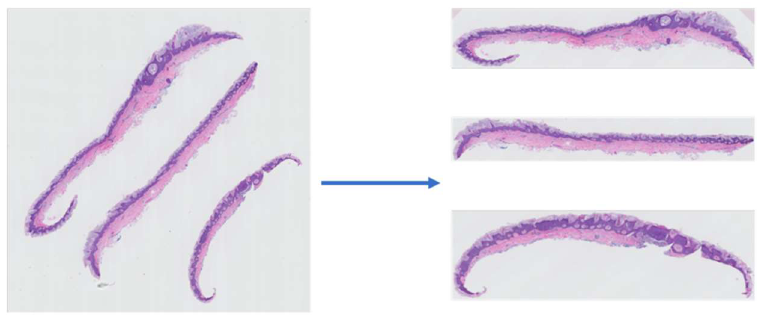
Figure 3. An example of a WSI ( left ) and its corresponding slice extraction ( right ).